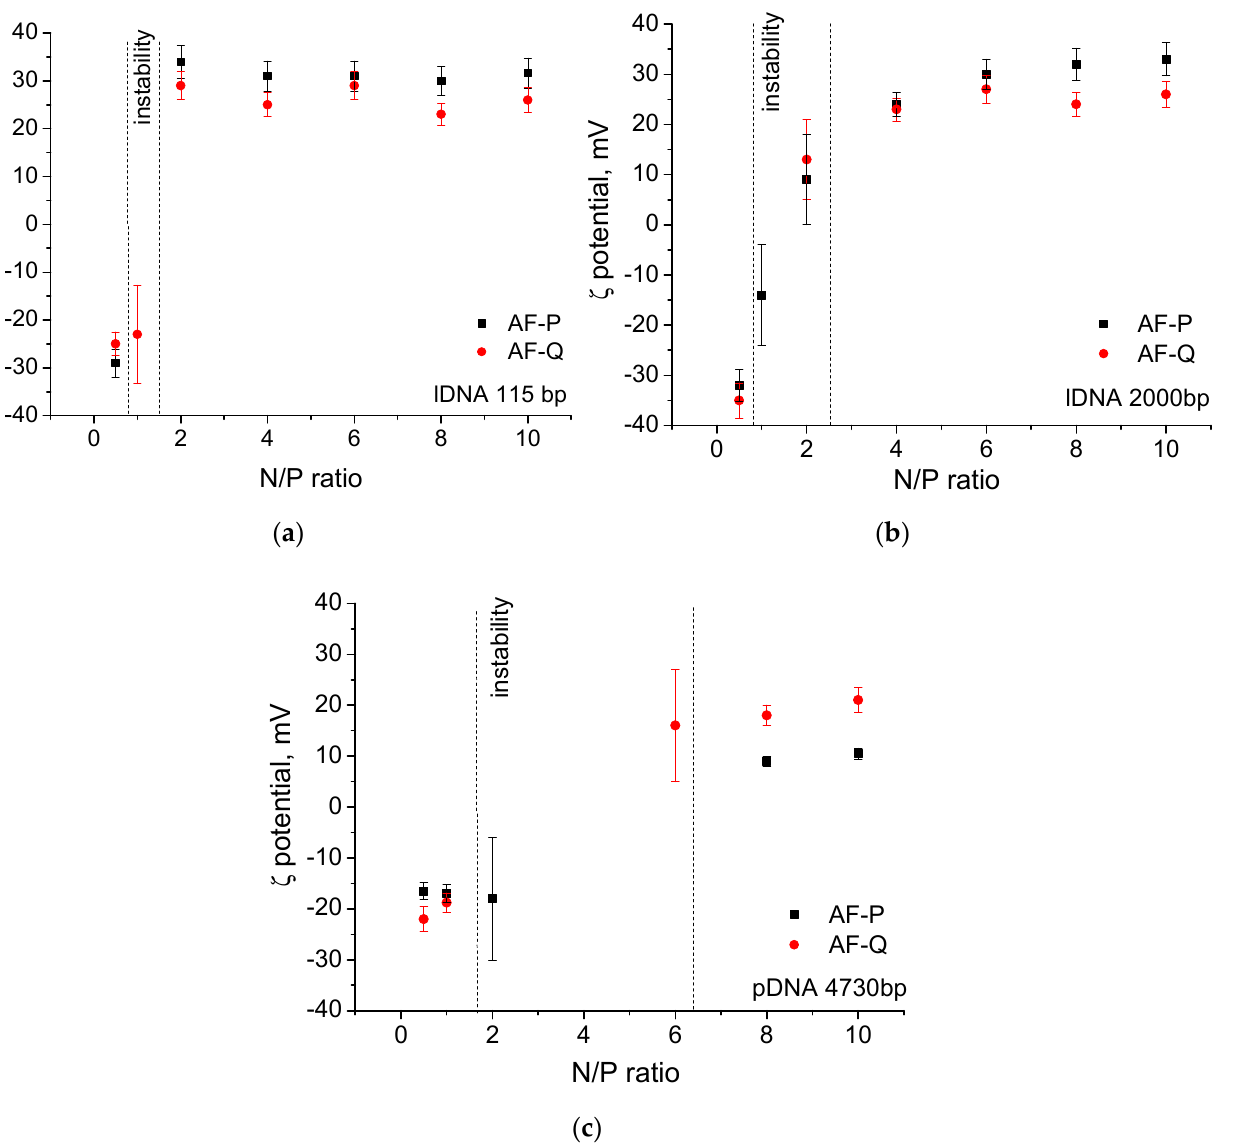
Figure 3. Variations of the ζ potential with the N/P ratio of polyplexes based on PDMAEMA star-shaped polymers prepared with ( a ) lDNA 115, ( b ) lDNA 2000 and ( c ) pDNA 4730.